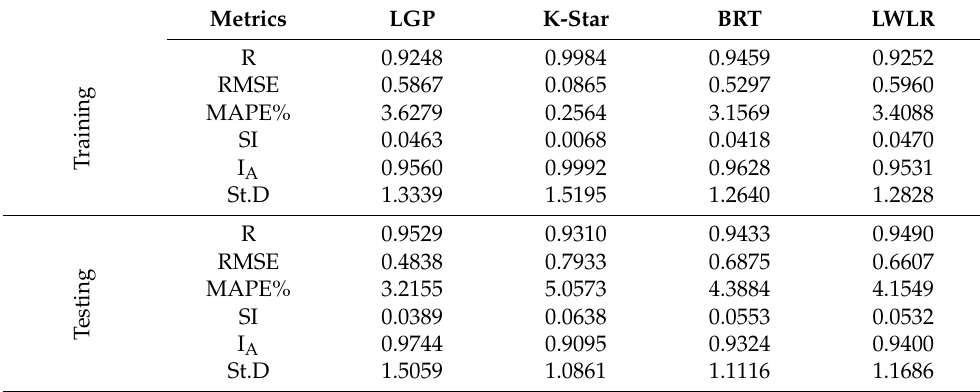
Figure 7. Comparison of four soft computing approaches and observed BI using scatter plot.